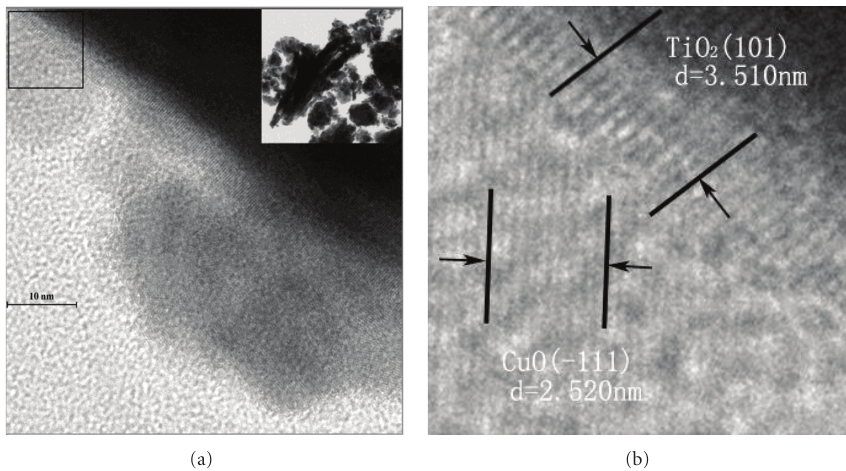
Figure 3: TEM and HR-TEM images of CuO (1.0 wt.%)/F-TiO 2 photocatalyst: (a) TEM image, (b) HR-TEM